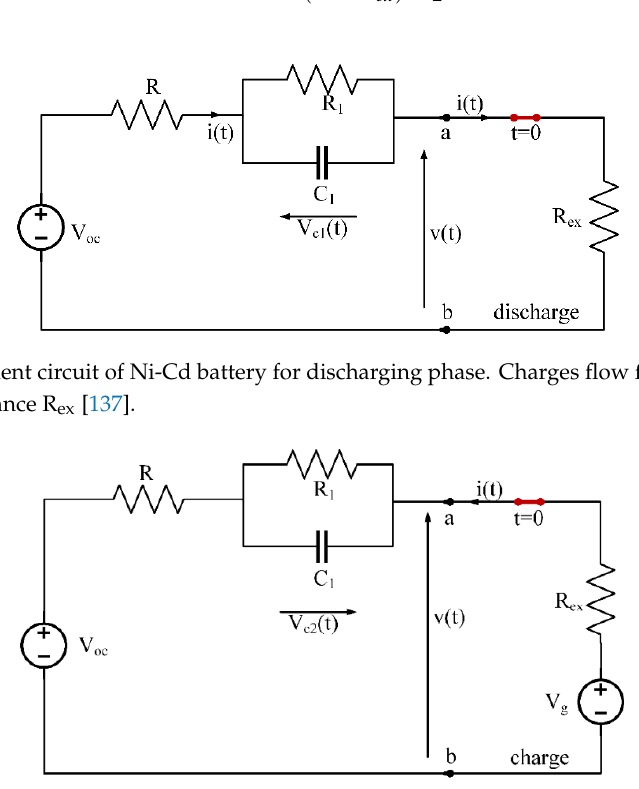
Figure 42. Equivalent circuit of Ni-Cd battery for charging phase. Charges flow from 𝑉 𝑔 and 𝑅 𝑒𝑥 towards 𝑉 𝑂𝐶 [137].